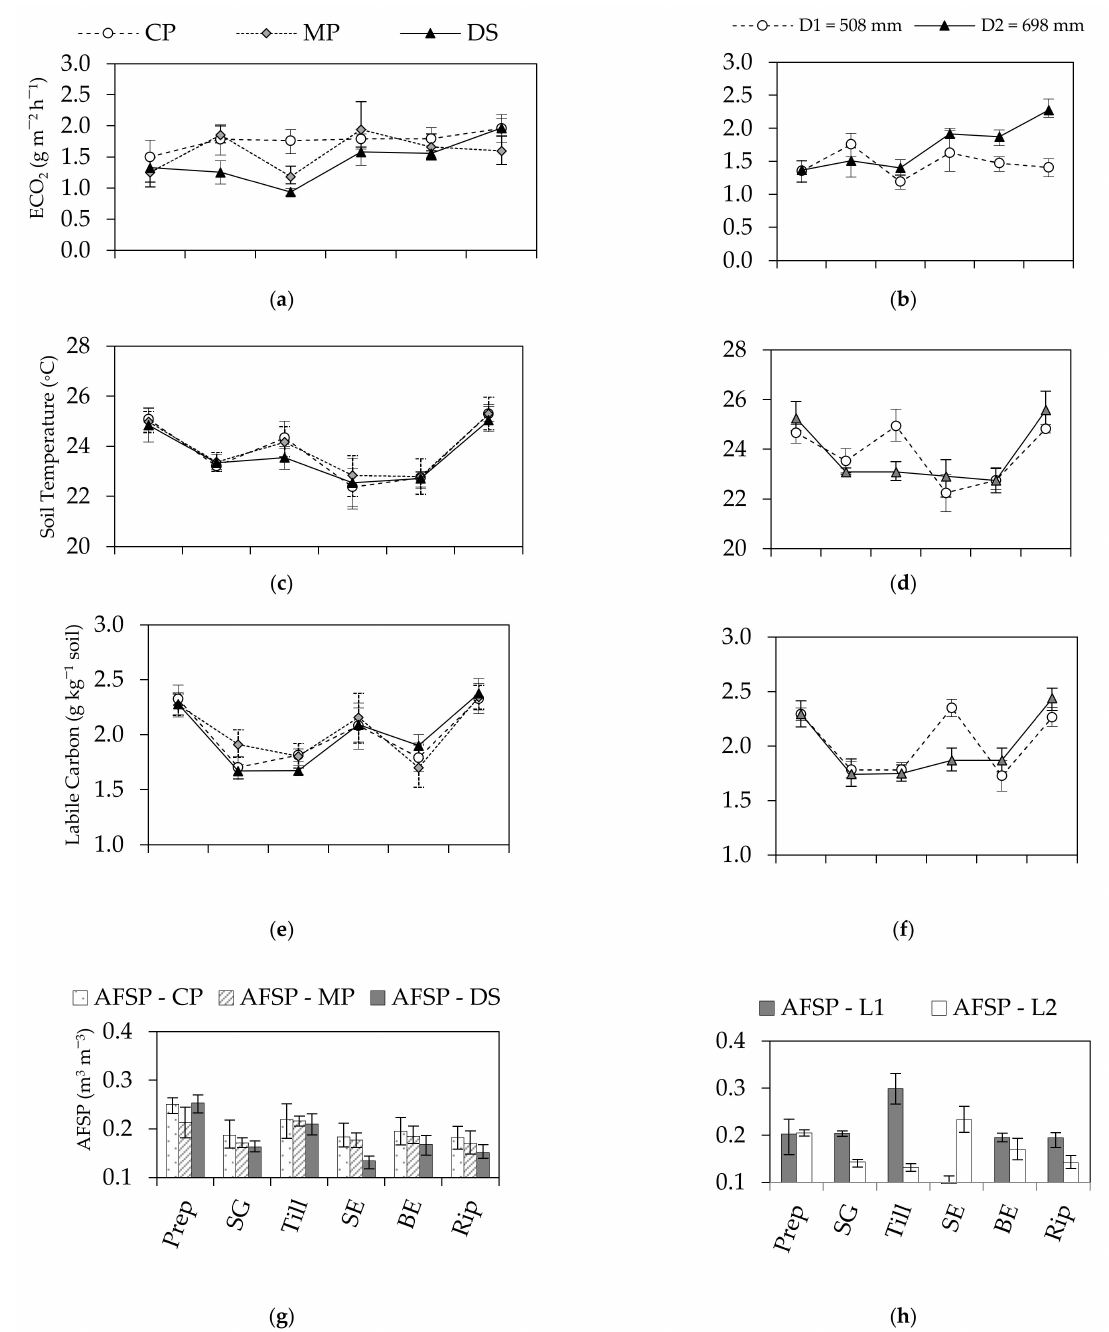
Figure 3. ( a , c , e , g ) Effect of Soil Preparation, Growth Stage of Wheat; ( b , d , f , h ) Effect of Irrigation Depth, Growth Stage of Wheat; ( a , b ) ECO 2 (g m − 2 h − 1 ); ( c , d ) Soil Temperature ( ◦ C); ( e , f ) Labile Carbon (g kg − 1 soil); ( g , h ) AFSP (m 3 m − 3 ); ( a – h ) Mean CO 2 Efflux (ECO 2 ), soil temperature, labile carbon, and Air-Filled Soil Pore (AFSP) space in response to variable soil preparation and irrigation depth, throughout six stages of development of wheat collected over 2 years (2011 and 2012) of measurements: Prep = soil Preparation (measurement made 4 h after soil turning); SG = Seedling Growth; Till = Tillering; SE = Stem Elongation; BE = Booting Emergence; Rip =